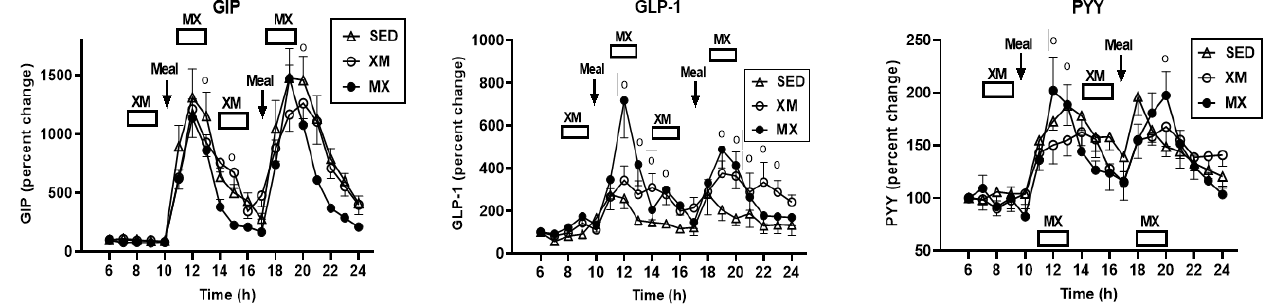
Figure 11. Exercise- and meal-timing effects on GIP, GLP-1, and PYY concentrations. Circle superscripts identify time slices when group differences were significantly different . XM = exercise before meals, MX = exercise after meals, SED = sedentary group.